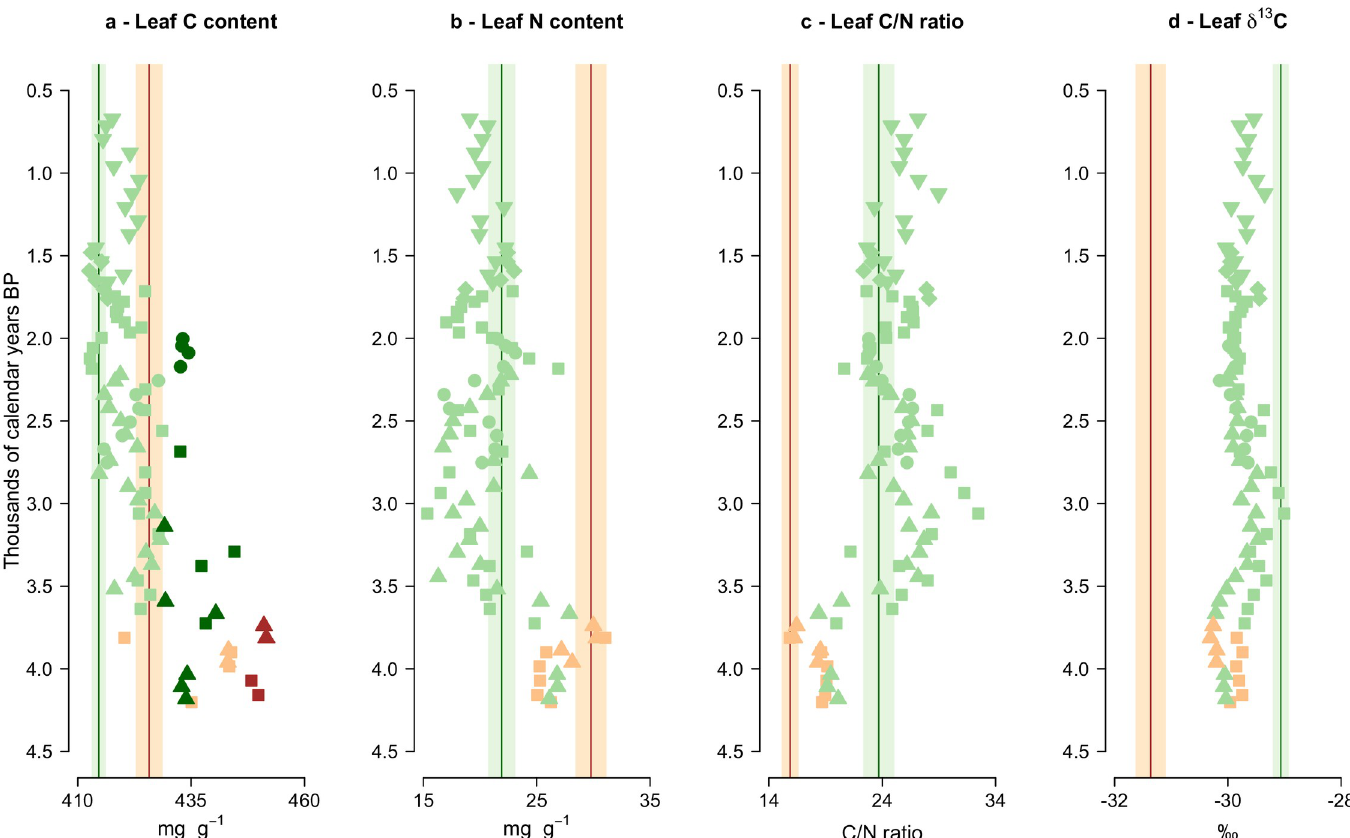
Fig 5. Changes in trait community weighted means (CWMs) through time (in thousands of calendar years before present) of the Holocene pollen-derived leaf trait records from five Fenland sites (circles = Murrow; squares = Redmere; diamonds = Swineshead; point-up triangles = Welney Washes 3 rd peat; point-down triangles = Welney Washes 4 th peat). Green and brown symbols indicate the predominance of herbaceous and woody taxa in the Holocene record, respectively. The means of the modern vegetation (i.e., plant-based data) are shown for herb (green vertical lines) and woody (brown vertical lines) fens. Shaded areas around the modern means depict their 95% confidence intervals. Darker-coloured symbols show Holocene samples significantly different from their equivalent (herbaceous or woody) modern vegetation means at p < 0.05 (one-observation t -tests).